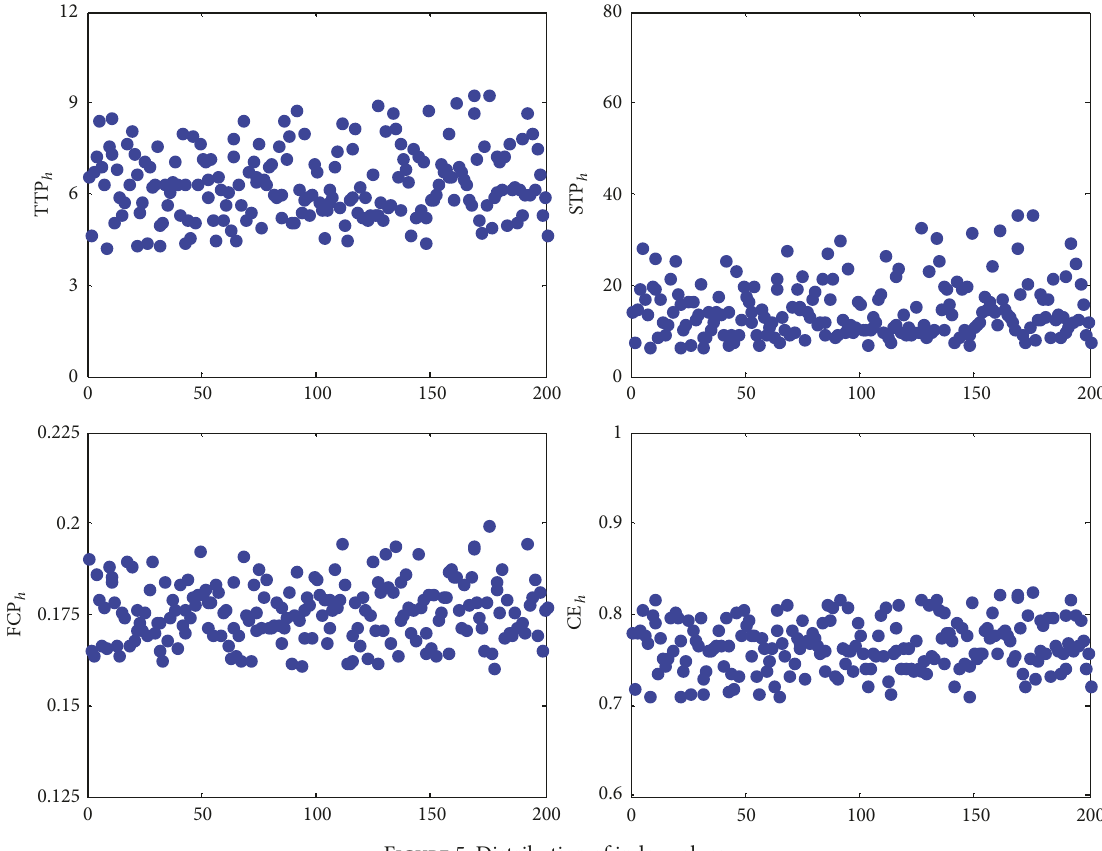
Figure 5: Distribution of index